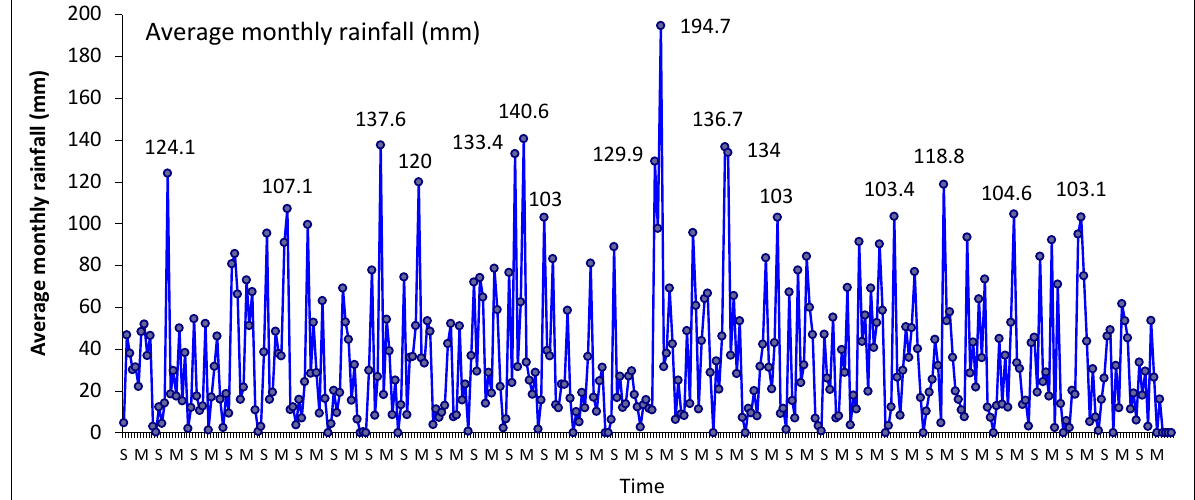
Figure 27. Average monthly variations in precipitation at the Hammam Grouz rainfall station (1987/88 -2016/2017) The average monthly rain recorded during this period is around 35 mm. However, the largest quantities fall successively in the winter and spring seasons. In fact, the irregularity of precipitation results in dry years with a maximum of monthly rains which does not exceed 54 mm, this is the case for 2016/2017 hydrological year where the maximum quantity is in January it is 53.7 mm. As it can translate into exceptional rainy years. This is the case for the year 2002/2003 (annual total: 666.9 mm) where the amount of rainfall in January, around 197.4 mm, exceeds the annual total for 2016/2017 which is 180, 5 mm. During this period, fluctuations are observed at peak precipitation exceeding 100 mm. Indeed, these values can put the body of water beyond its normal level and consequently the appearance more of the problem in question. This makes it essential to represent the hydrological years of these peaks and especially the year when the largest peak of 197.4 mm is observed, this is the year 2002/2003. Figure 28 represents the monthly variation of the rain at the rainfall station of the Hammam Grouz dam in 2002/2003 hydrological year.